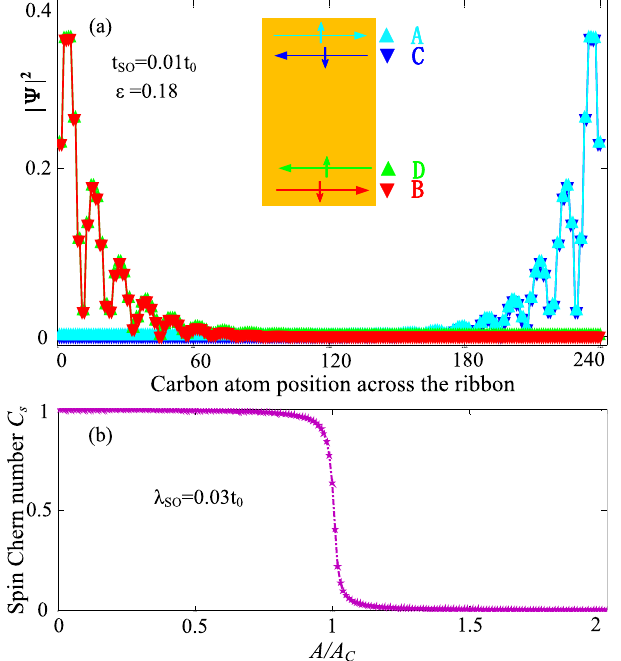
Figure 4. ( a ) Probability densities of the wave functions of the edge states labeled by A, B, C, D in Fig. 3(c), the inset is the schematics which indicate the propagation directions of the edge modes. ( b ) The calculated spin Chern numbers within the continuum Dirac model as a function of strain A with λ = . t 0 03 is set to be 240 carbon